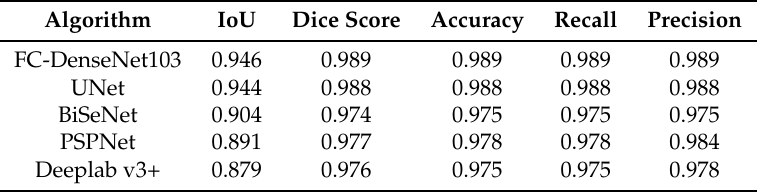
Table 3. Metrics measured for every segmentation algorithm.